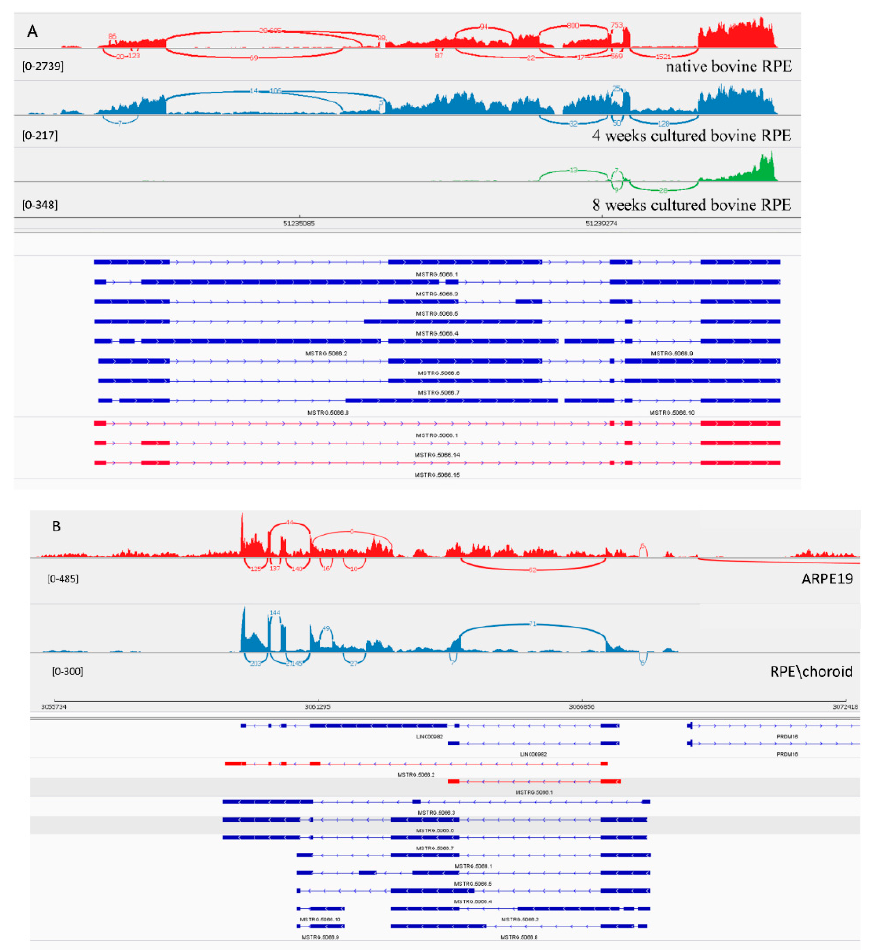
Figure 3. View of MSTRG.5066 from the Integrated Genome Viewer (IGV). IGV–Sashimi plots showing the read coverage and transcript isoforms. The histograms represent the sum of the aligned sequencing reads along the genome. Numbers in square brackets indicate coverage range. Junction reads are plotted as arcs, and the number of reads aligned to the junction spanning the exons connected by the arc is indicated. ( a ) Sashimi plots from bovine genome; red histogram represents the coverage for native bovine RPE, blue is 4-week cultured bovine RPE, and green is 8 weeks cultured bovine RPE. Below the histograms are shown the predicted isoforms (blue), experimentally verified in this study (red). ( b ) Sashimi plots from human genome; red histogram represents coverage for ARPE-19 cells and blue represents the native human RPE/choroid. Below the histograms are shown the GenBank or predicted isoforms (blue) and experimentally verified isoforms in this study (red).